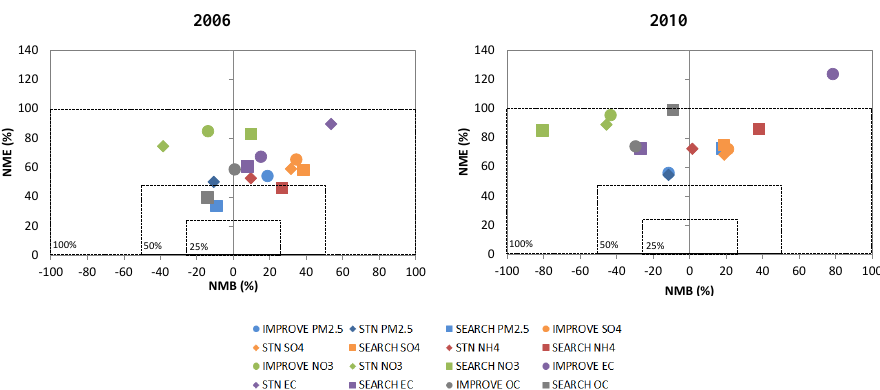
Figure 7. Plots of annual statistics (NMB vs. NME) for average 24h PM 2 . 5 concentrations and PM 2 . 5 species against different observational networks.